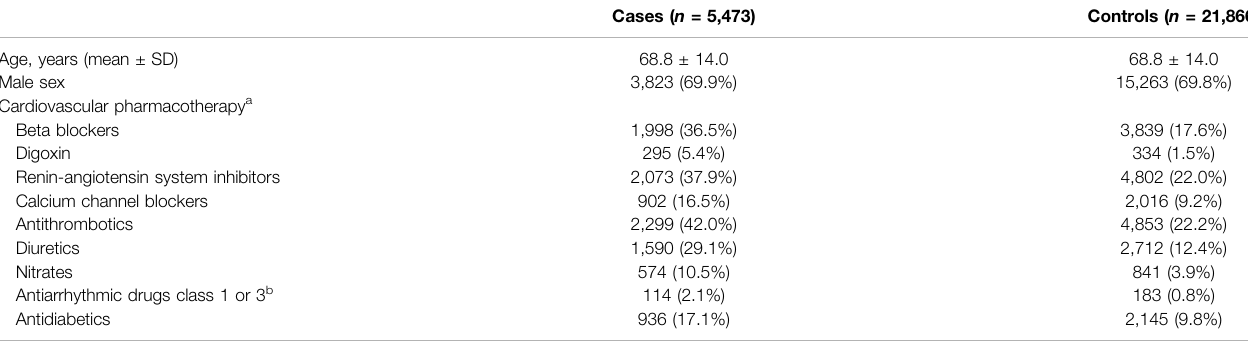
TABLE 2 | Characteristics of cases and controls.